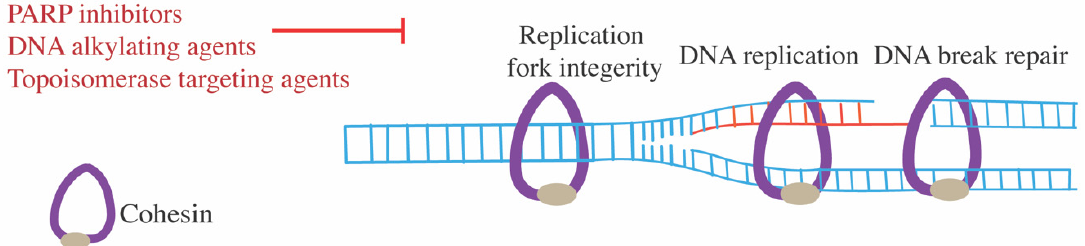
Figure 3. Cohesin’s role in DNA repair. Tightly regulated cohesin dynamics at replication fork ensures its integrity and restart of replication stress-induced stalled fork. Cohesin at DNA breaks facilitates homologous recombination mediated repair. Agents that disrupt DNA repair or DNA replication have been shown to have an increased inhibitory effect on cohesin-insufficient or -depleted cells.